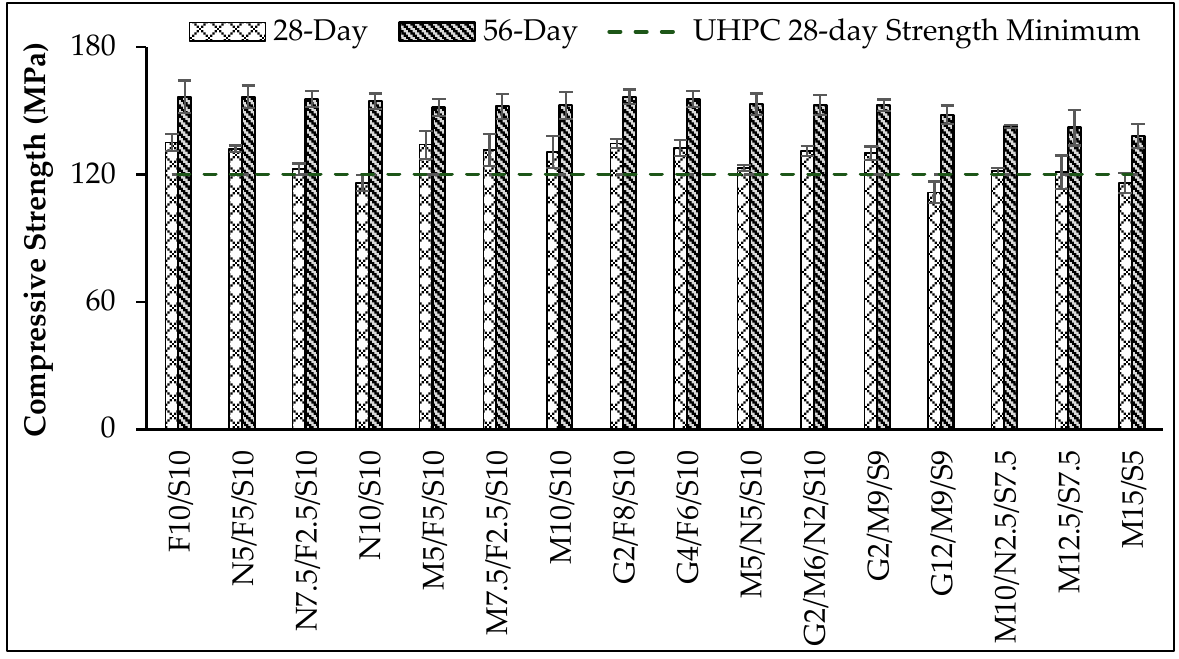
Figure 7. Compressive strength results.